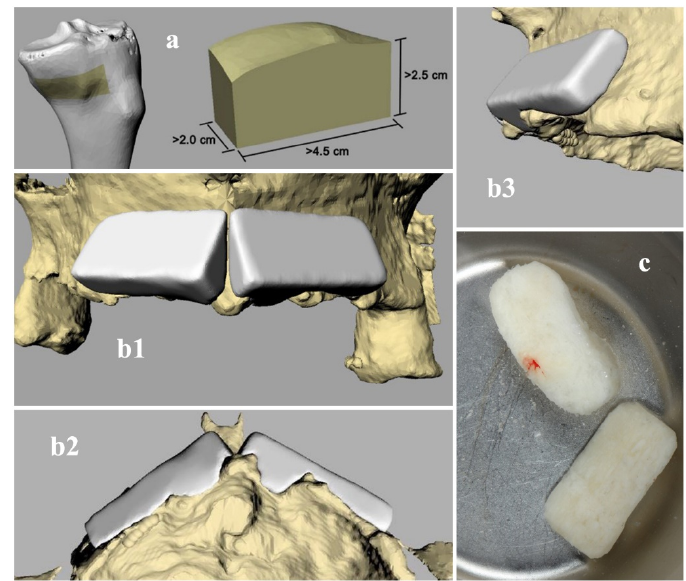
Figure 2. (a) Render of 3D bone donor site harvested from a cadaver tibial hemiplateau. (b1–b3) Render of 3D reconstruction of patient's anatomy (yellow) and designed bone grafts (white). (c) Final block for clinical use.